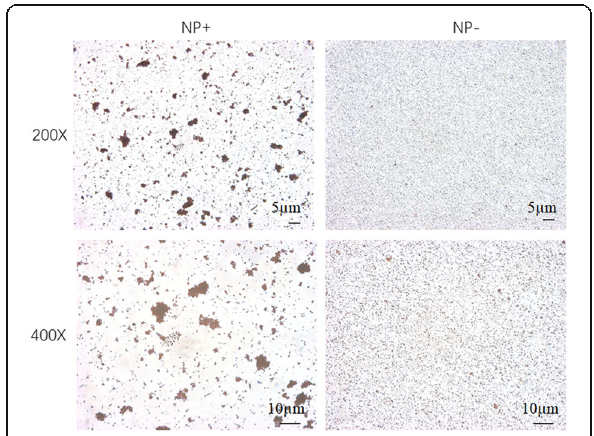
Fig. 4 Comparison of E. coli binding capacity of NP+ and NP − . The left images are the phase-contrast fields of bacteria binding with NP+. The right images only have nanoparticles, suggesting that NP − without binding capacity to E. coli